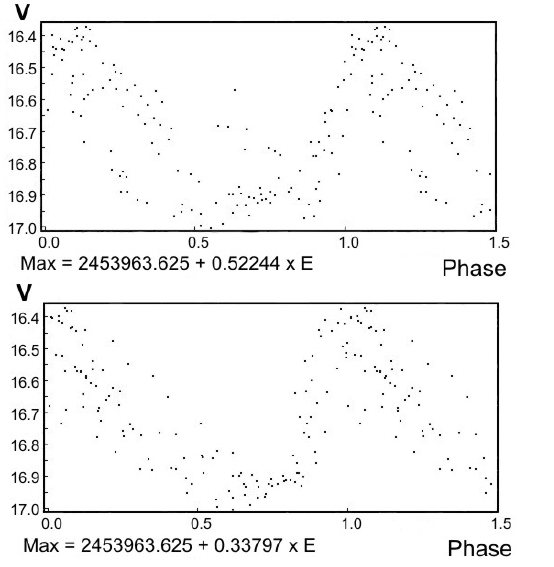
Figure 1. Top: the light curve of V3 (M14) with the RRAB elements. Bottom: same data with the RRC